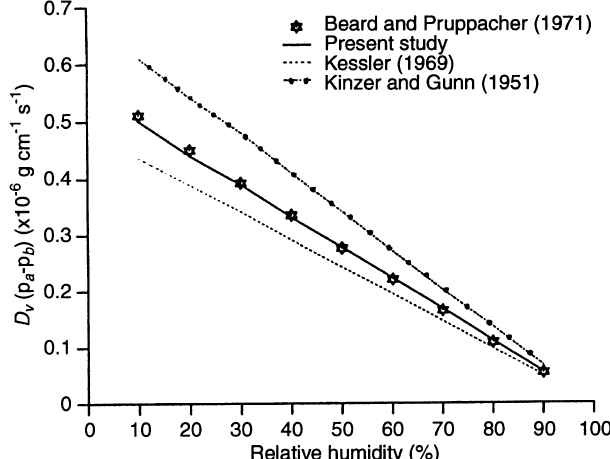
(cid:255) (cid:113) (cid:134) as a function of a p